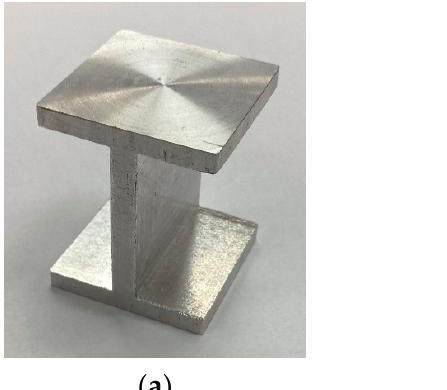
( b ) Figure 8. Simulation results (a) all of the solution; (b) 5 most favourable solutions (with vector lengths). The corresponding fin width and fin numbers can be seen in Table 5. It can be stated that because of the error of the L vector length the first three solutions are acceptable; yet the Pareto-vector length optimum is the case when there was one 6 mm wide fin in the airflow. Table 5. Cases and vector lengths. Fin Width (mm)